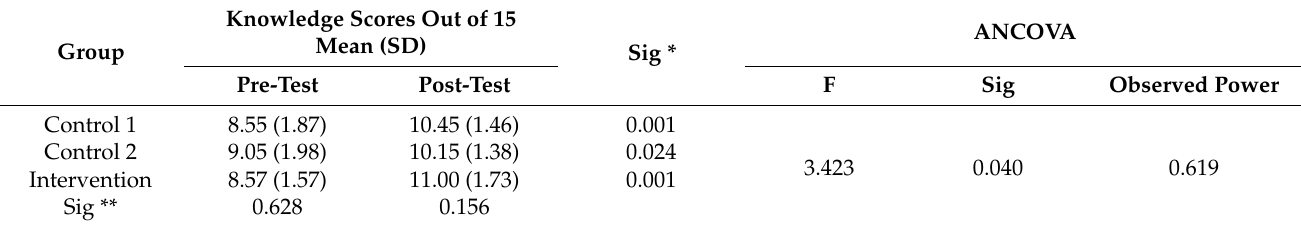
Table 2. Within and among group comparison of the knowledge pre- and post-test scores.